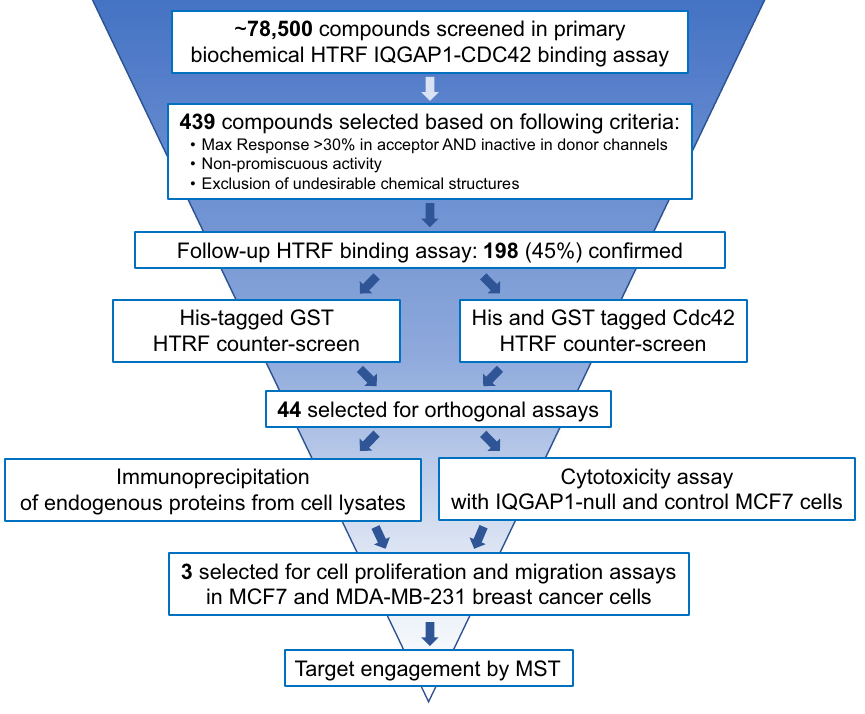
Figure 2. Compound identification and validation flow chart. Depicted is the funnel of the assays, filtering, and analyses performed for identification of the most prominent chemotypes of clusters and singletons selected for further